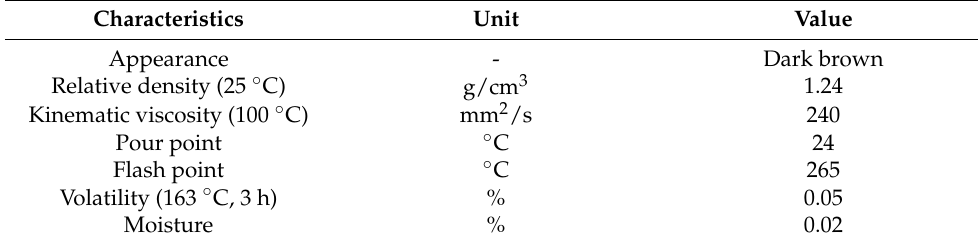
Table 2. Physical properties of the